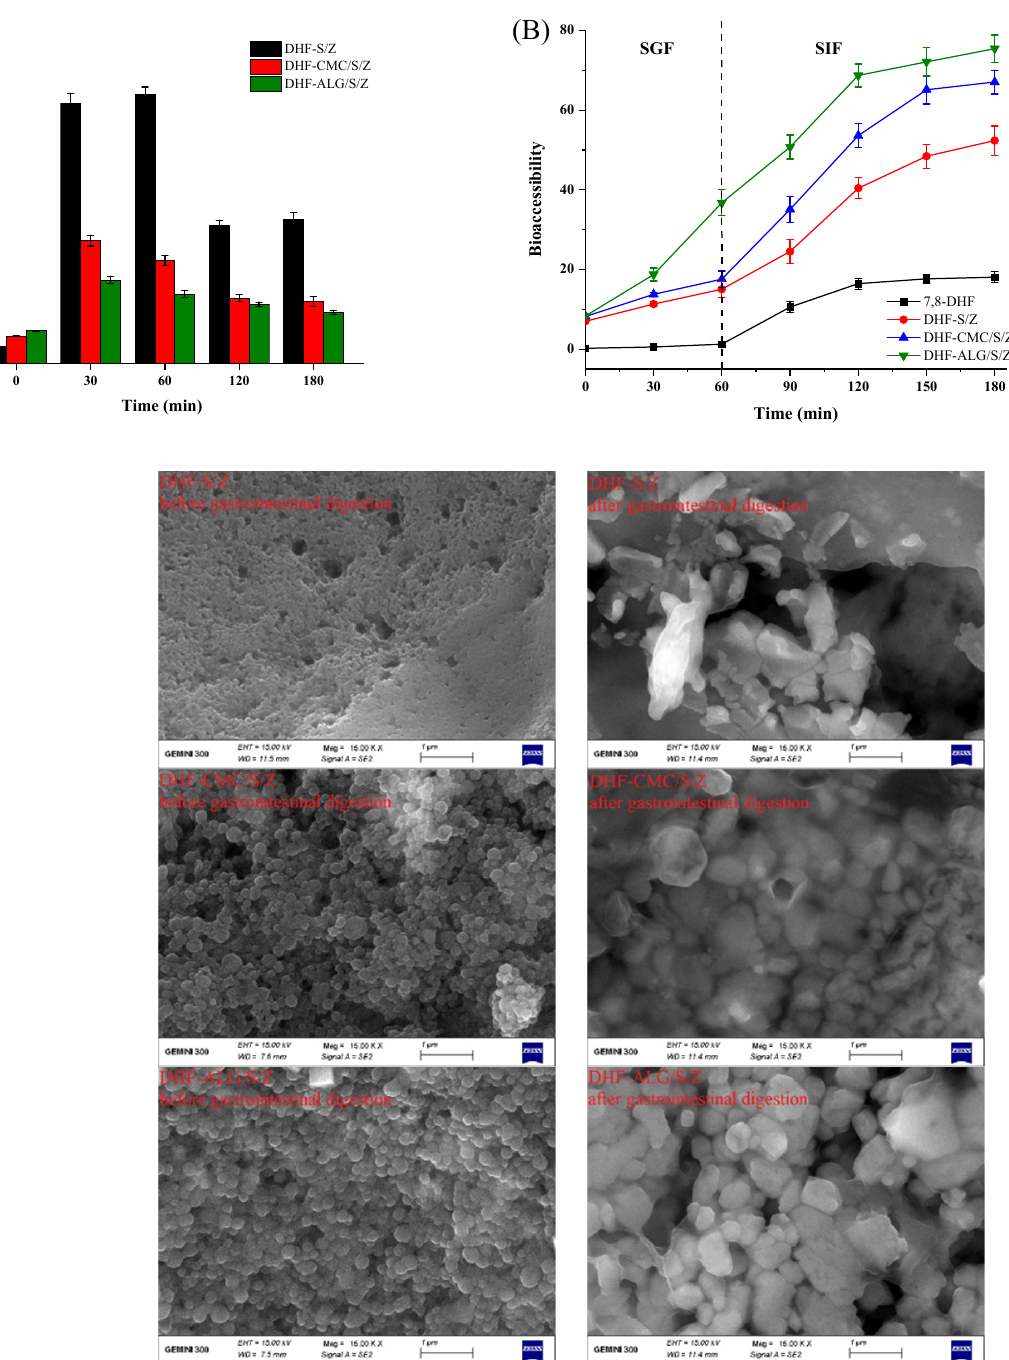
Figure 9. Influence of in vitro digestion time on the particle size ( A ) and bio-accessibility of DHF-S/Z, DHF-CMC/S/Z, and DHF-ALG/S/Z ( B ), FE-SEM images of DHF-S/Z, DHF-CMC/S/Z, and DHF-ALG/S/Z, 15,000× magnification times ( C ).